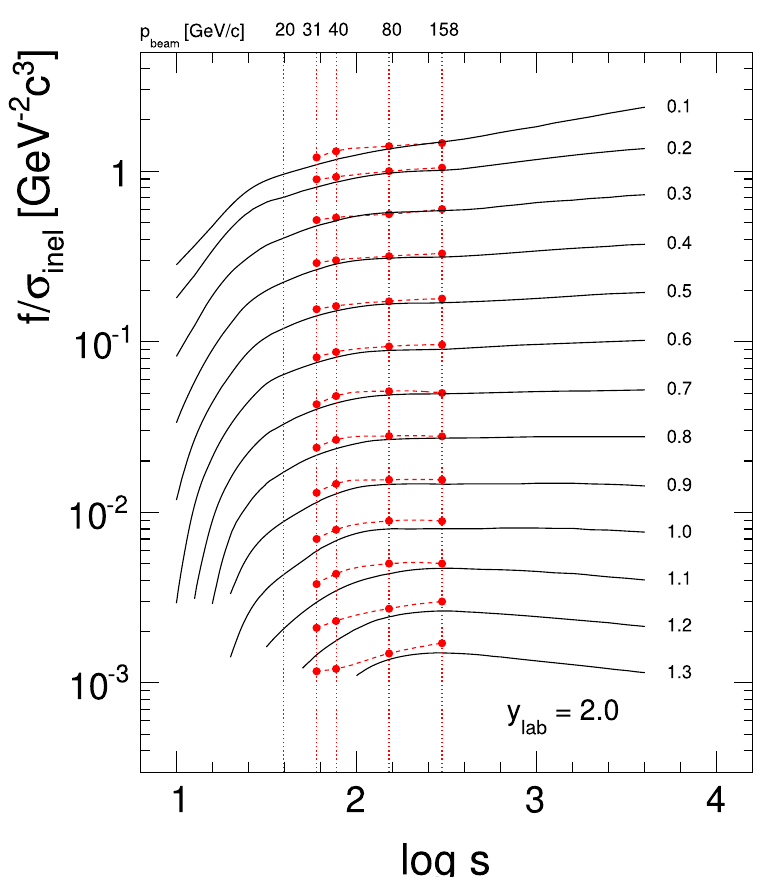
Fig. 68 Cross sections f /σ inel as functions of p T and y lab for y lab = 2.0. The full lines represent the global interpolation, the data points the NA61 results. The broken lines are eyeball fits to these data demonstrating the smooth s -dependence of the